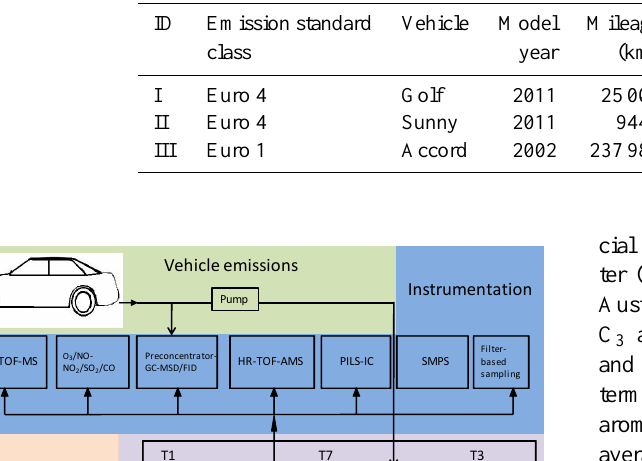
Table 1. Detailed information of the three LDGVs.